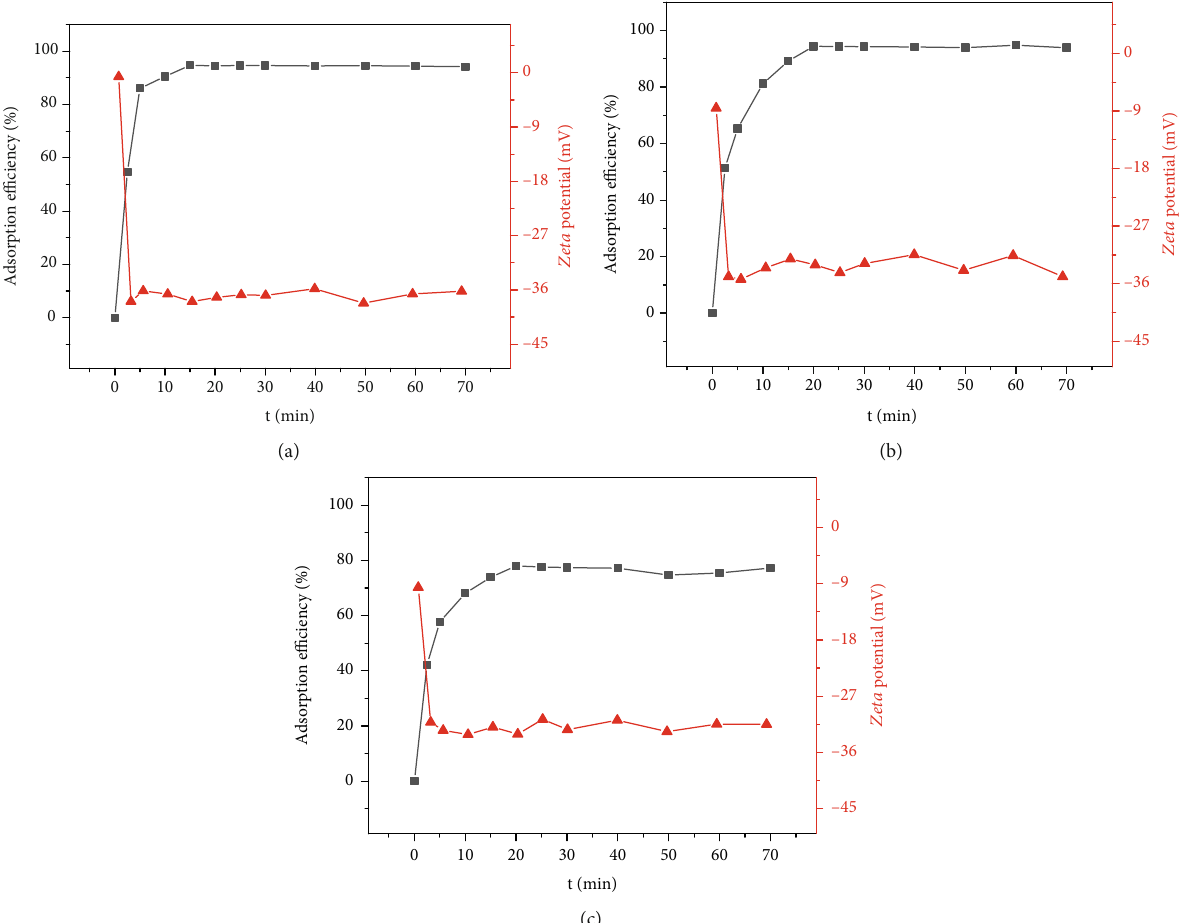
Figure 1: Adsorption e ffi ciency and Zeta potential of Pb 2+ (a), Cd 2+ (b), and Ni 2+ (c) adsorption on